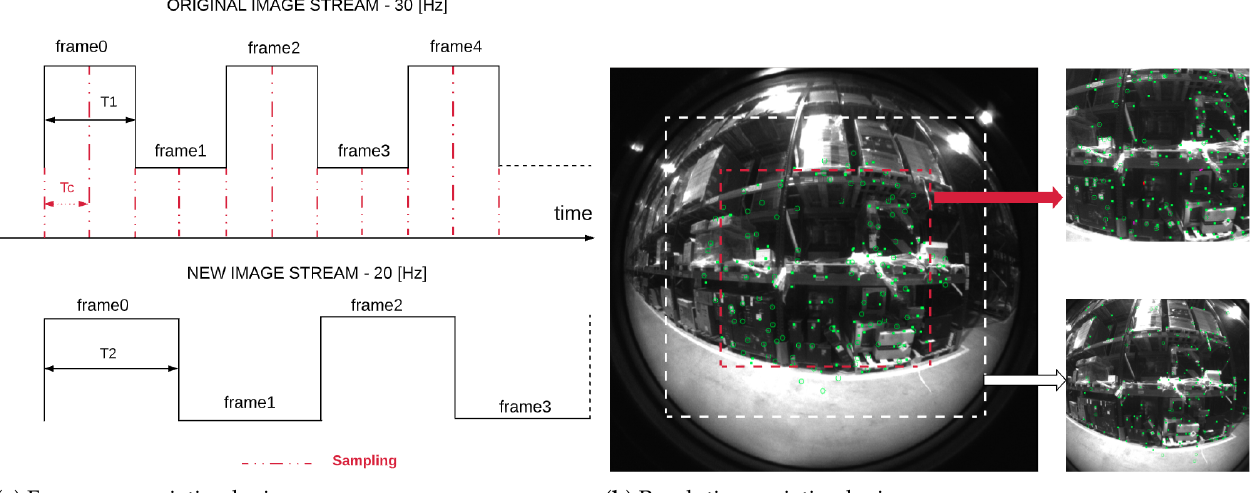
Figure 4. ( a ) Streaming video frequency variation example from 30 Hz to 20 Hz. ( b ) Decrease in resolution from 848 × 800 px on the center of the